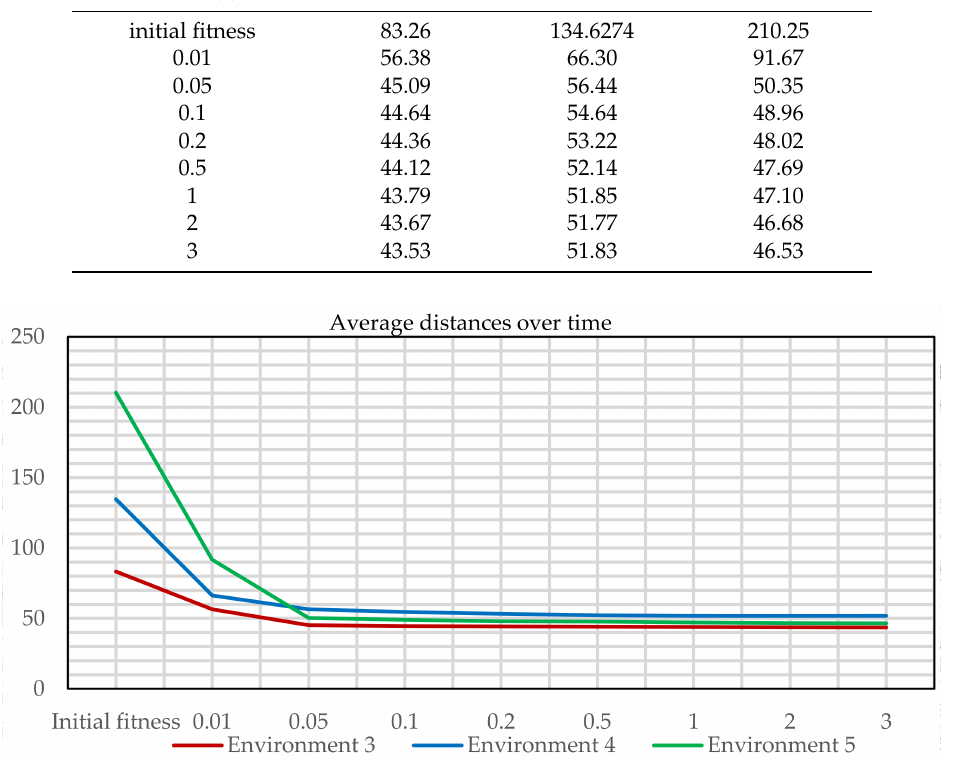
Figure 24. Plot of average distances over